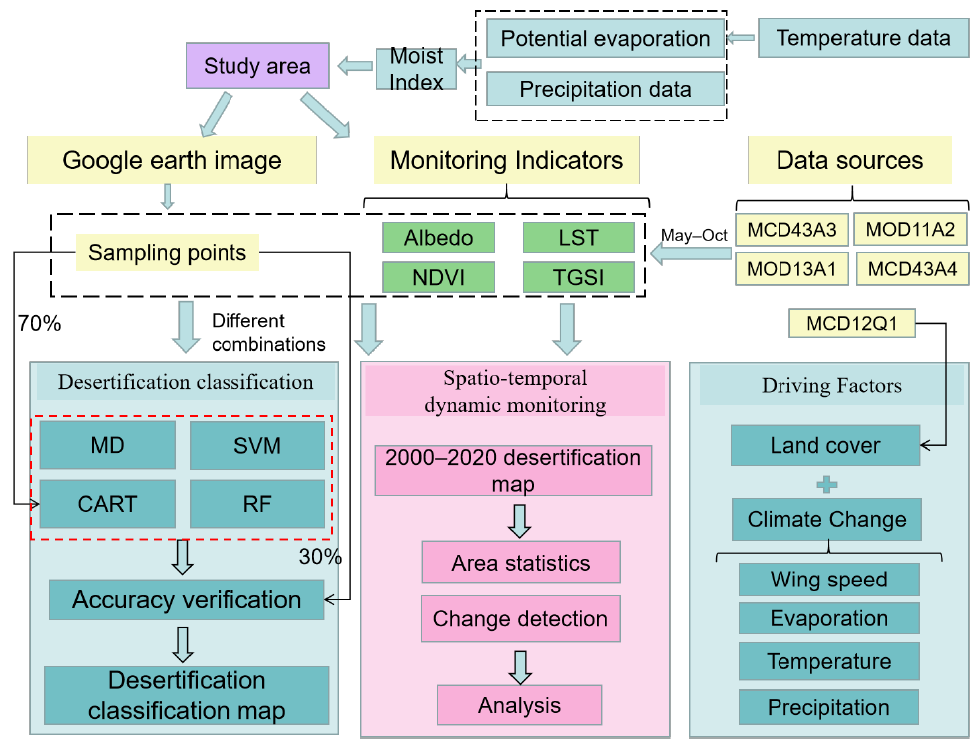
Figure 1. The total flowchart of this study. MD, SVM, CART, and RF stand for minimum distance, support vector machine, classification and regression tree, and random forest, respectively. LST is land surface temperature, NDVI is normalized difference vegetation index, and TGSI is topsoil grain size index.